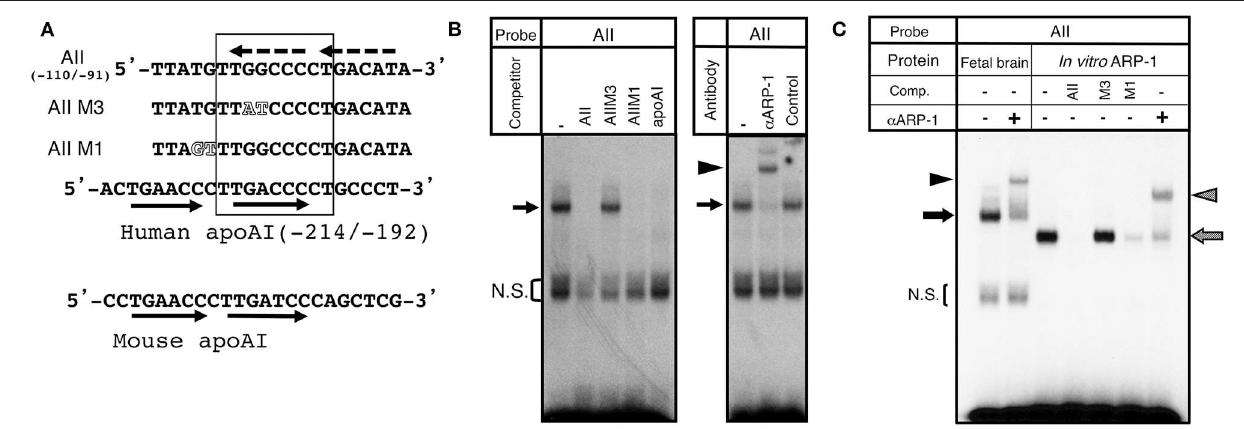
FIGURE 2 | Identification of ARP-1 as a candidate binding protein of the aro-AII site. (A) The aro-AII-binding protein recognized the sequence “TTGGCCCCT,” which is shown inside the square. The wild-type and mutant oligonucleotide probes, AII, AIIM1, and AIIM3, are shown. Mutations introduced into the aro-AII oligonucleotide are shown by outlined characters. The nucleotide sequence of the ARP-1 binding site in the promoter region of the human and mouse ApoAI gene is also shown in the figure. Tandem repeats of human and mouse ApoAI oligonucleotides are shown in the oligonucleotide by arrows. The box indicates the portion of nucleotides essential for ARP-1 binding as described in our previous report. The putative tandem repeats in the AII probe are shown by broken arrows. (B) A gel shift assay was performed using 5 µ g of nuclear protein. A 200-fold molar excess of unlabeled probe was used in the competition assay. The specific signals are indicated by the arrow on left side. The bracket shows the non-specific signals (N.S.). (C) For supershift assays, nuclear protein was incubated with 2 µ g of the indicated antibody on ice for 30min before the addition of a radiolabeled probe. The probe/nuclear protein complex and supershift signals are indicated by the arrow and arrowhead, respectively, on the left